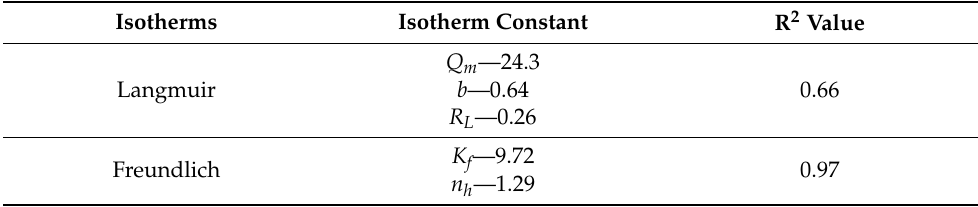
Figure 7. The isotherm studies of MB on PNB by using: ( a ) Langmuir model, and ( b ) the Freundlich model. Table 3. Adsorption parameters for MB onto the PNB adsorbent for both the Langmuir and Freundlich models.